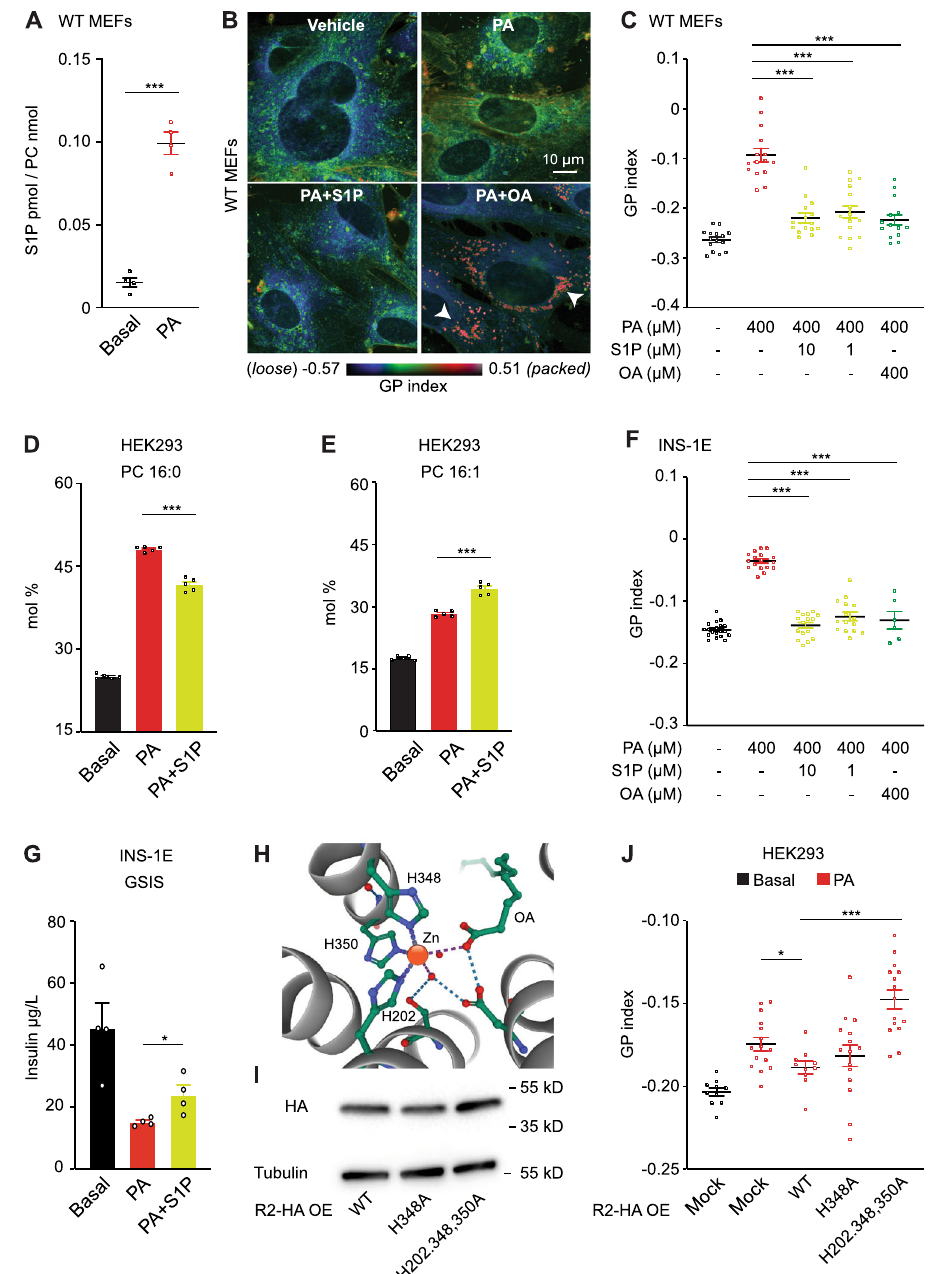
Fig. 3 | S1P promotes resistance against saturated fatty acids by improving membrane homeostasis in mammalian cells. A S1P abundance in WT MEFs±PA 400 µ M for 12h. n =4 biologically independent replicates for each